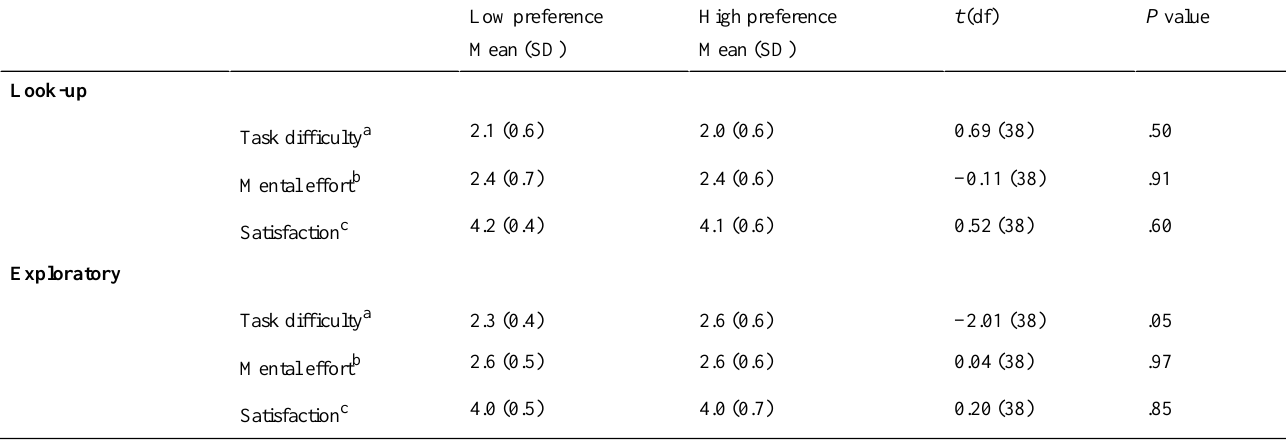
Table 7. Perceptions of task difficulty and task performance.